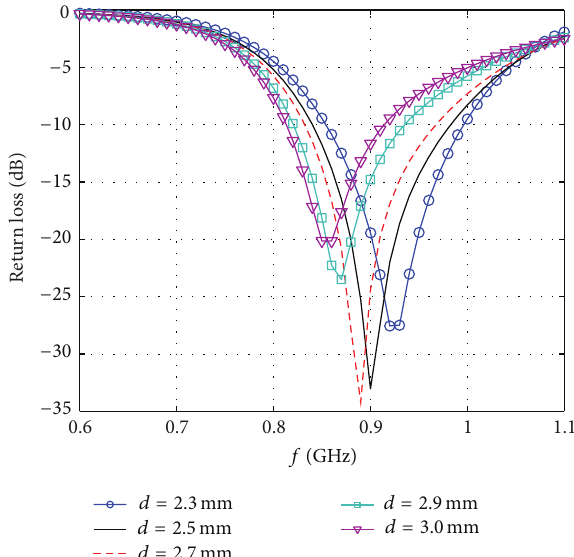
Figure 9: Comparison of S11 of the antenna with different 𝑑 .